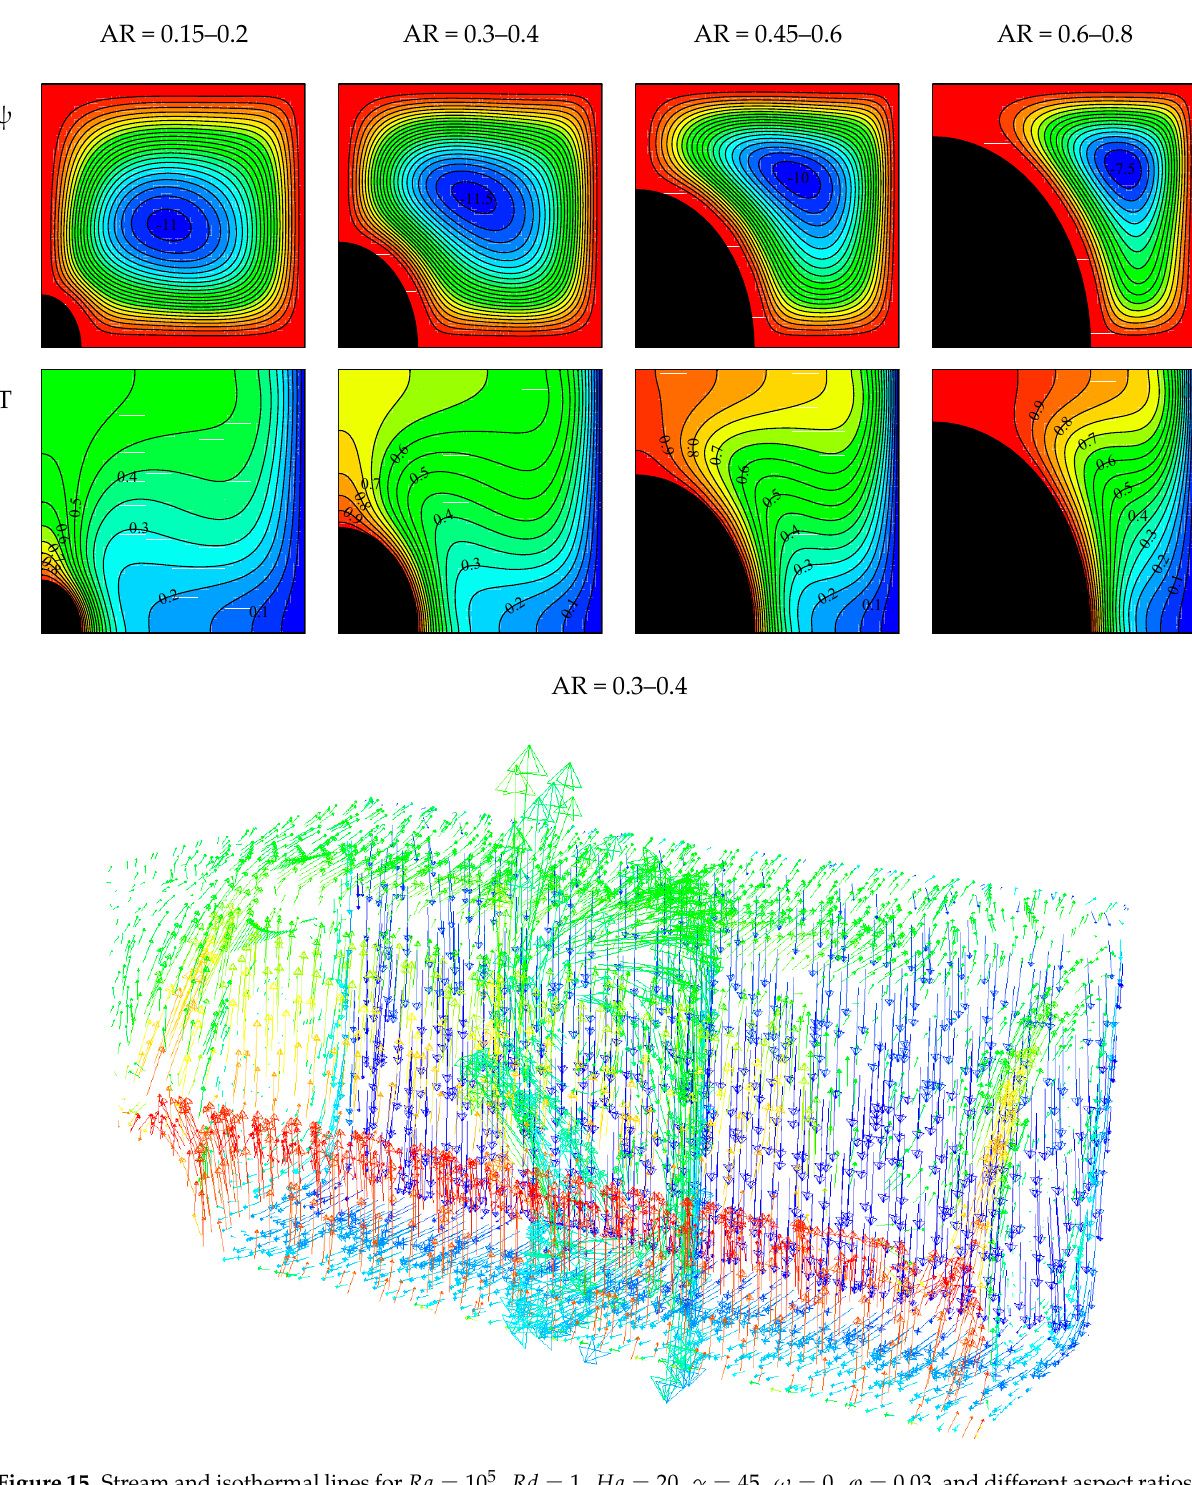
Figure 15. Stream and isothermal lines for Ra = 10 5 , Rd = 1, Ha = 20, γ = 45, ω = 0, ϕ = 0.03, and different aspect ratios. Table 5. Mid Nu, total EGE, and Be for 𝑅𝑎 = 10 (cid:2873) , 𝑅𝑑 = 1, 𝐻𝑎 = 20, 𝛾 = 45, 𝜔 = 0, 𝜑 = 0.03, and different aspect ratios.